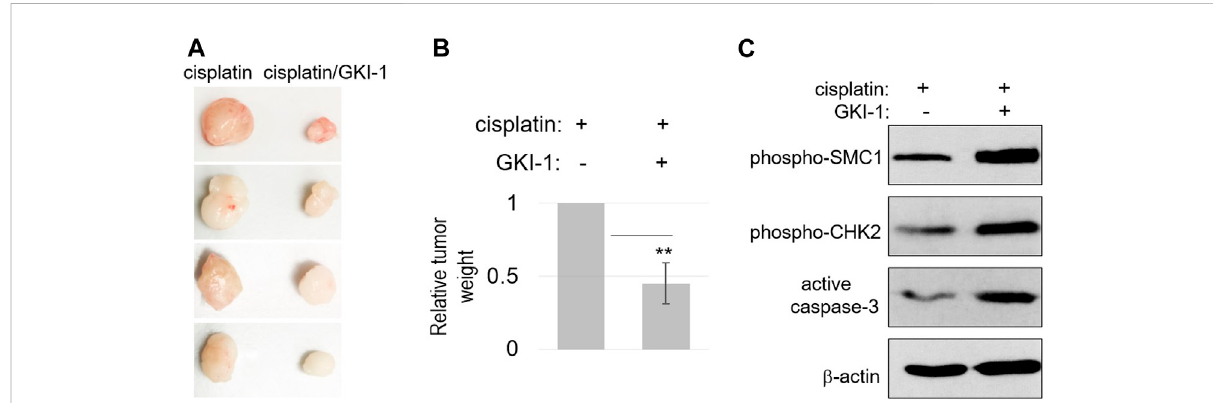
FIGURE 5 GKI-1 enhances the tumor response to cisplatin in vivo . (A – C) SCC38 xenograft tumor model was established, as described in Materials and Methods. Once tumor volume reached 100mm 3 , three doses of cisplatin and GKI-1 were administered Intraperitoneally with 3-day intervals. At the end of the study, tumors were excited and weighted. Tumor photos were shown in panel (A) . The mean values of tumor weight ( n = 4), standard deviation, and power analysis (2-tailed t-test) were shown in panel (B) . Tumor analysis by immunoblotting was shown in panel (C)